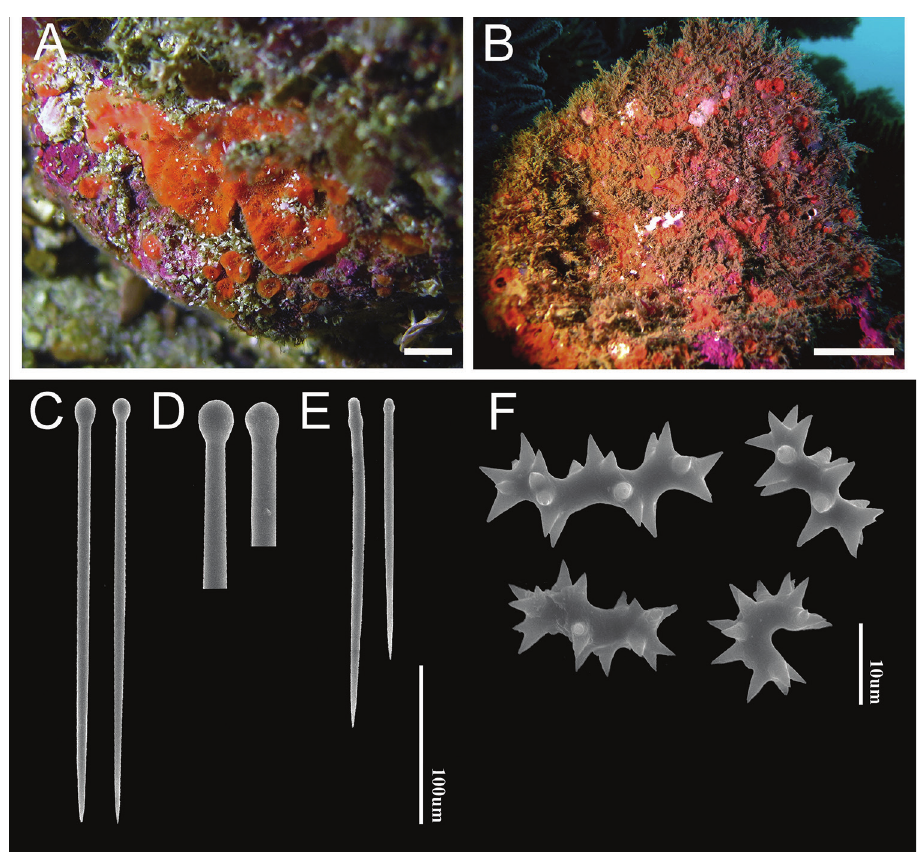
Figure 3. Cliona aff. euryphylle Topsent, 1888 A, B specimen alive in situ (CENAIM 160510EP07-01) collected at El Pelado Marine Reserve C large tylostyles D heads of tylostyles E small tylostyles F different sizes of spirasters with large spines. Scale-bars: 1 cm ( A ); 5 cm ( B ); 100 µm ( C–E ); 10 µm ( F